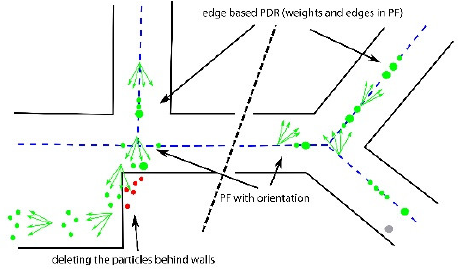
Figure 6. Graphical concept of edge-based PF [21]. To obtain a most likely position from the PF, the particle weights are